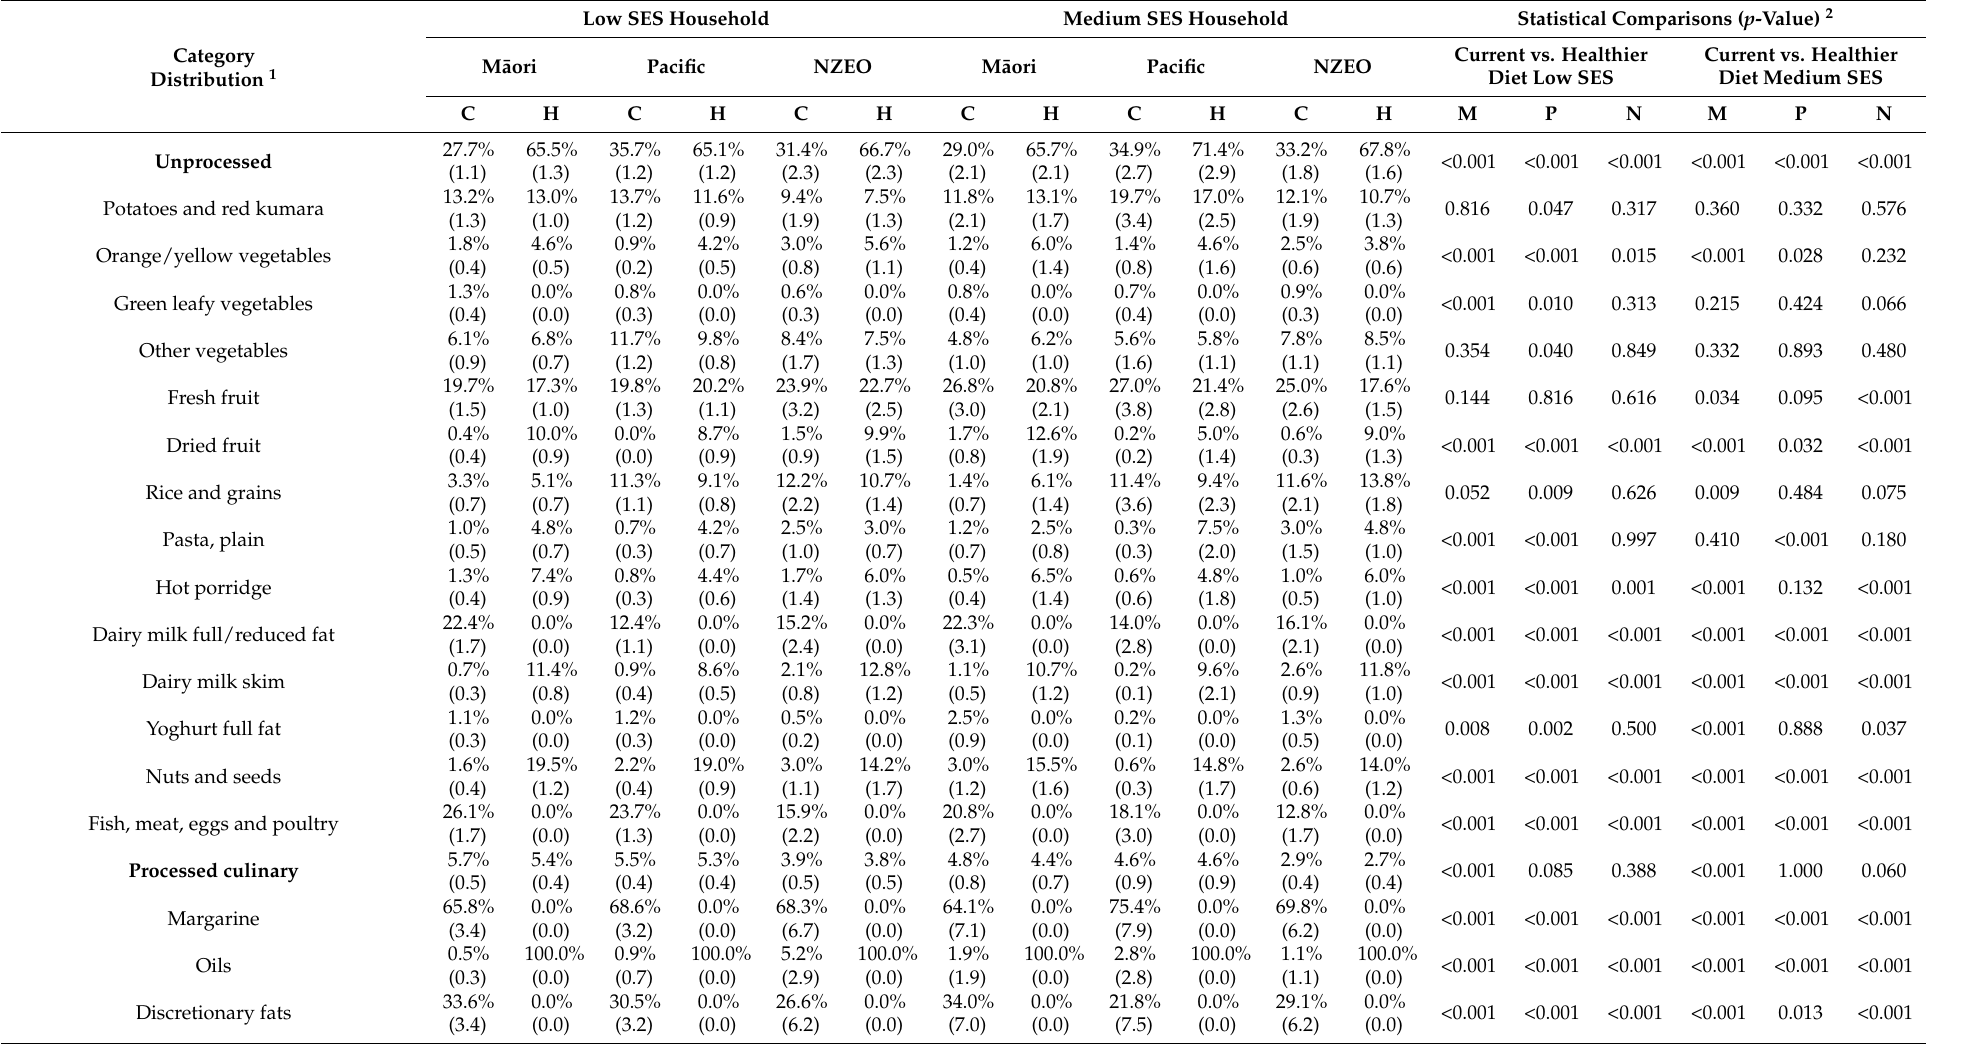
Table 5. Distribution of NOVA processing levels and food category types throughout the current and healthier diets for each ethnic group, and both low and medium SES households.